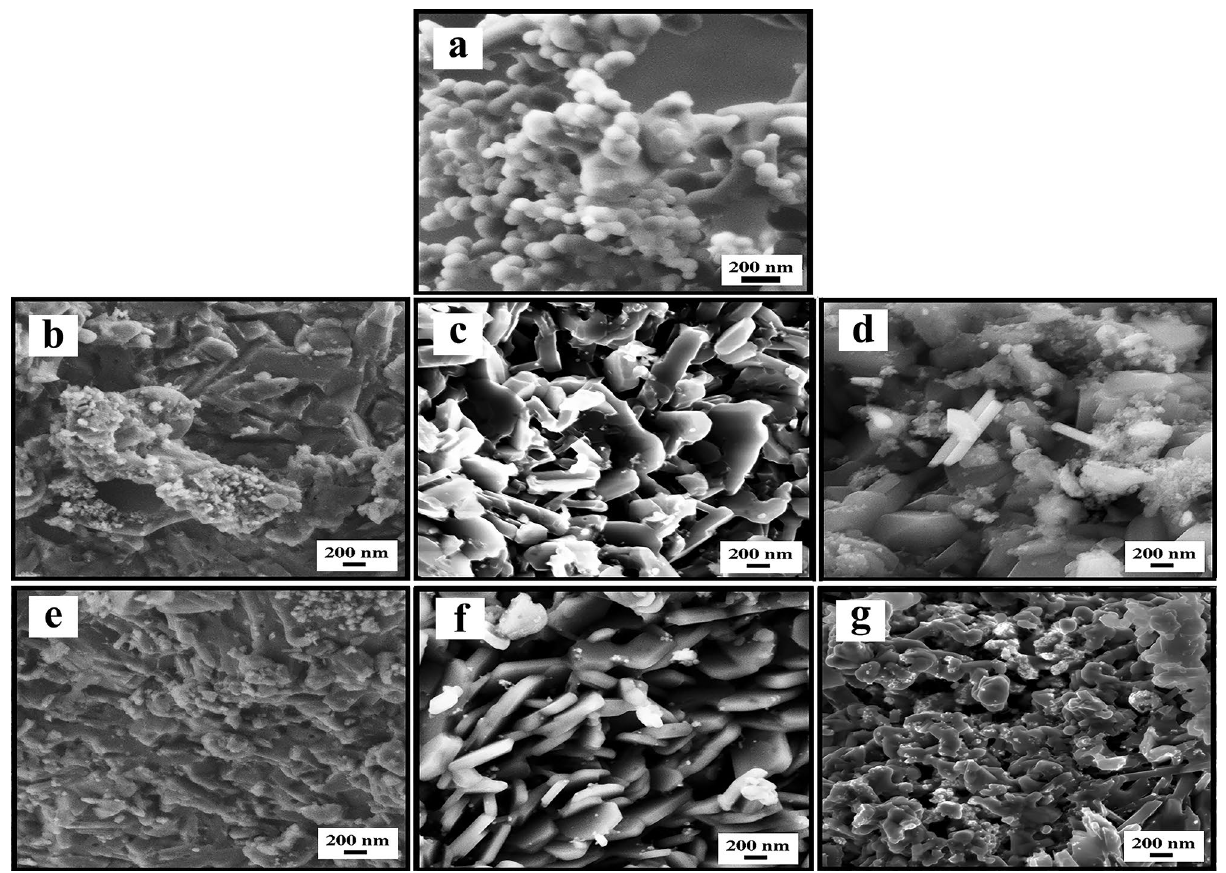
Figure 4. SEM images of ( a ) pure MgB 2 , ( b ) Mg 0.975 Co 0.025 B 2 , ( c ) Mg 0.95 Co 0.05 B 2 , ( d ) Mg 0.9 Co 0.1 B 2 , ( e ) Mg